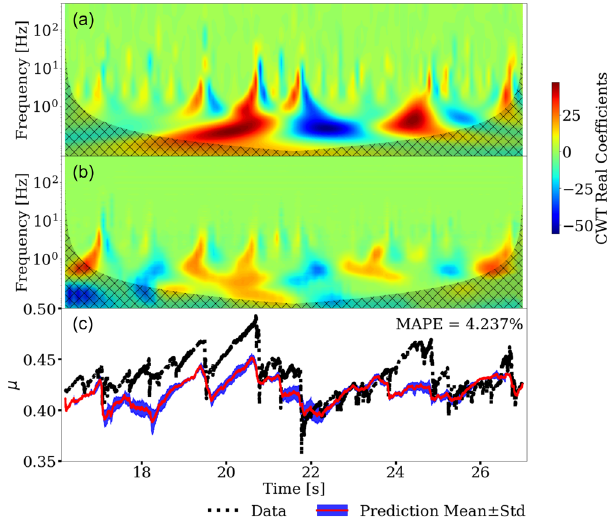
Fig. 4 Instantaneous frictional coef fi cient prediction from the convolutional encoder-decoder (CED) model trained on Finite-discrete element method (FDEM) simulation data. The a input and b predicted scalograms are shown, with the color bar indicating the continuous wavelet transform (CWT) real coef fi cients. The cross-hatched region in b indicates the cone of in fl uence where edge effects are important. The predictions from the CED are made applying sliding windows with 2 s length and step size of 0.2 s. The predicted scalogram is the average of all sliding windows. c The numerical simulation data (black line) and model-predicted friction coef fi cient μ from the inverse of the scalogram is shown in red with the blue region indicating 1-standard deviation for the predictions in the overlapping windows. The mean absolute percentage error (MAPE) is listed for the numerical simulation and predicted